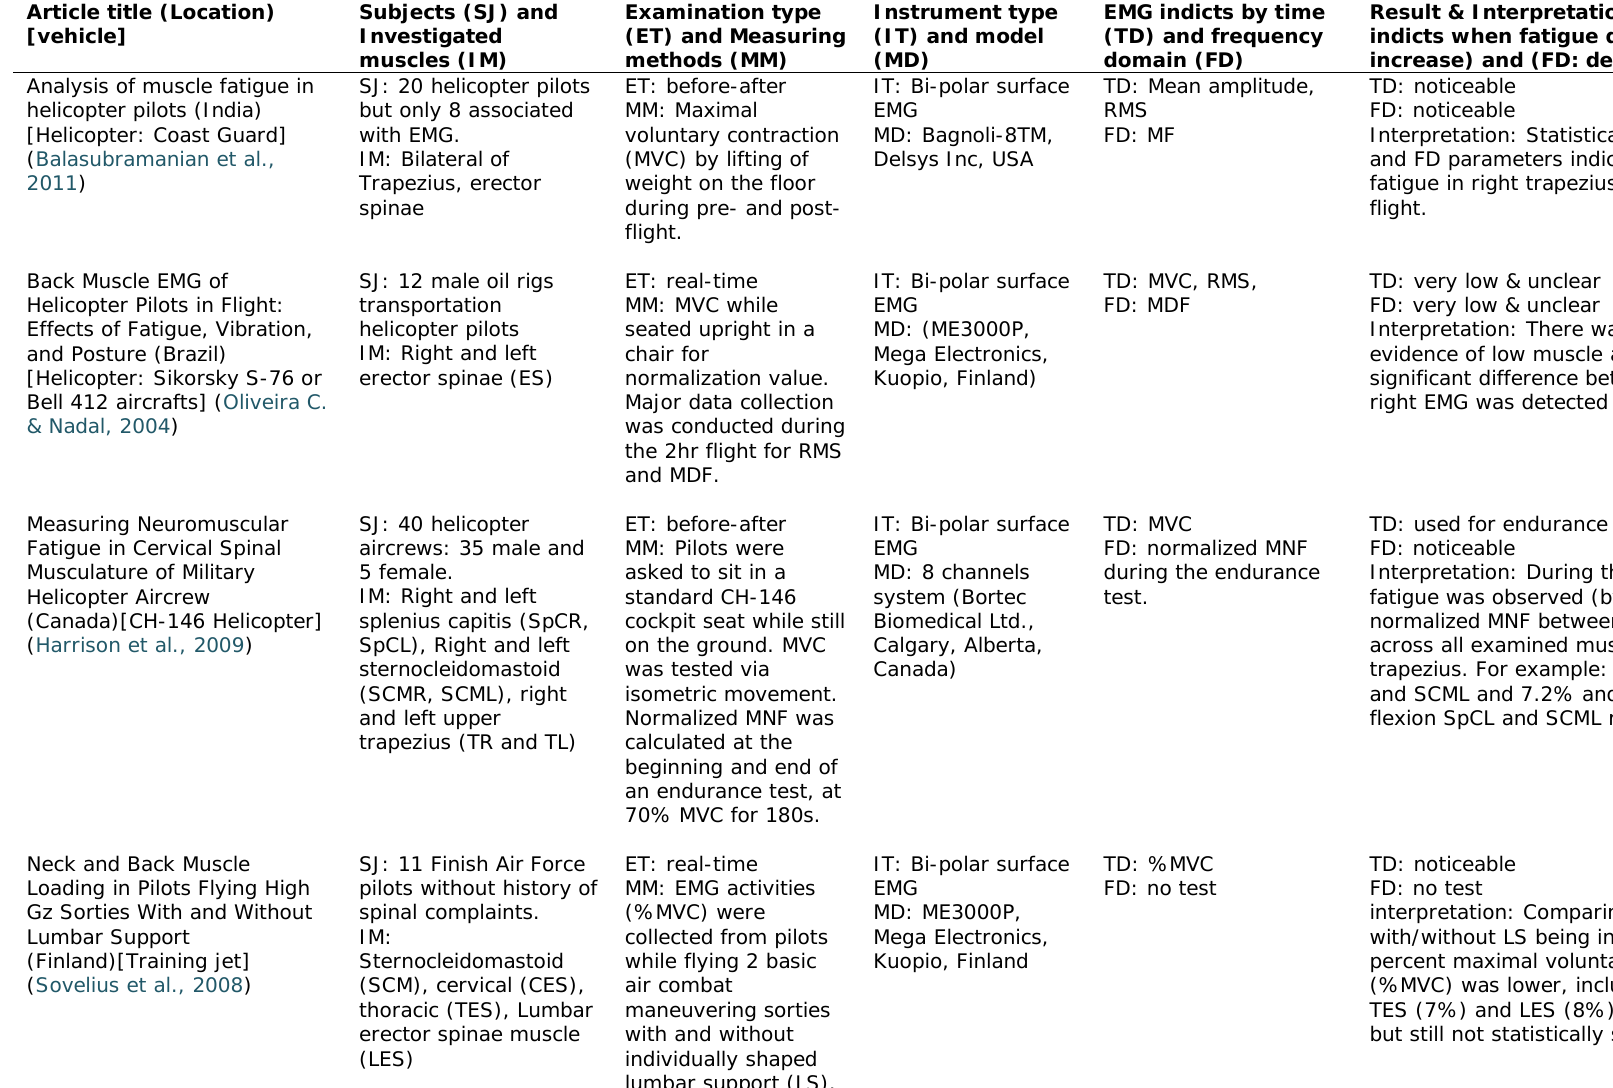
Table 2. Studies of air transportation/transshipment associated vehicles (4 studies) Article title (Location)